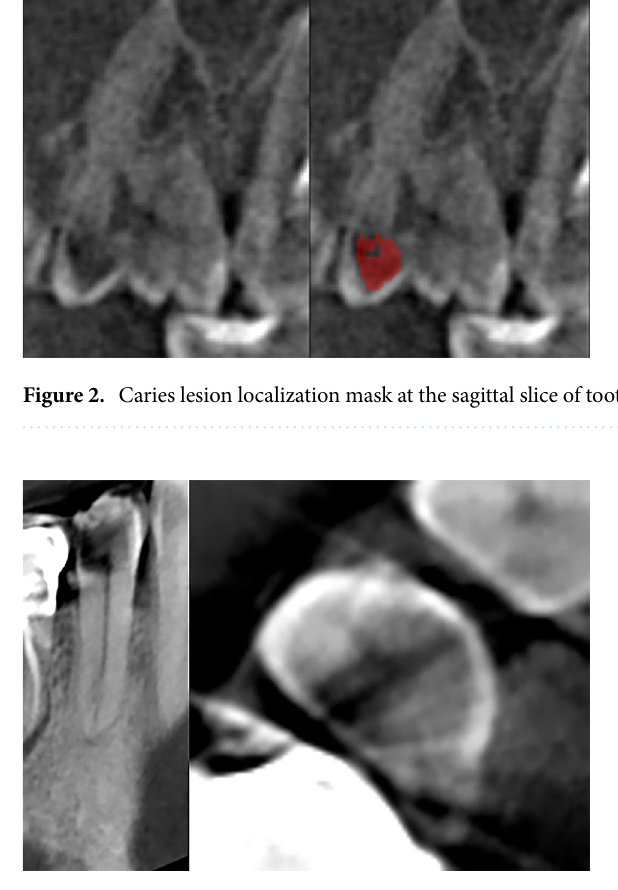
Figure 3. Caries lesion at mesiodistal and axial slices of tooth 45. No caries predicted by caries localization module. The identification of caries was overlooked due to metallic artifacts which is an example of incorrect classification by the AI system.